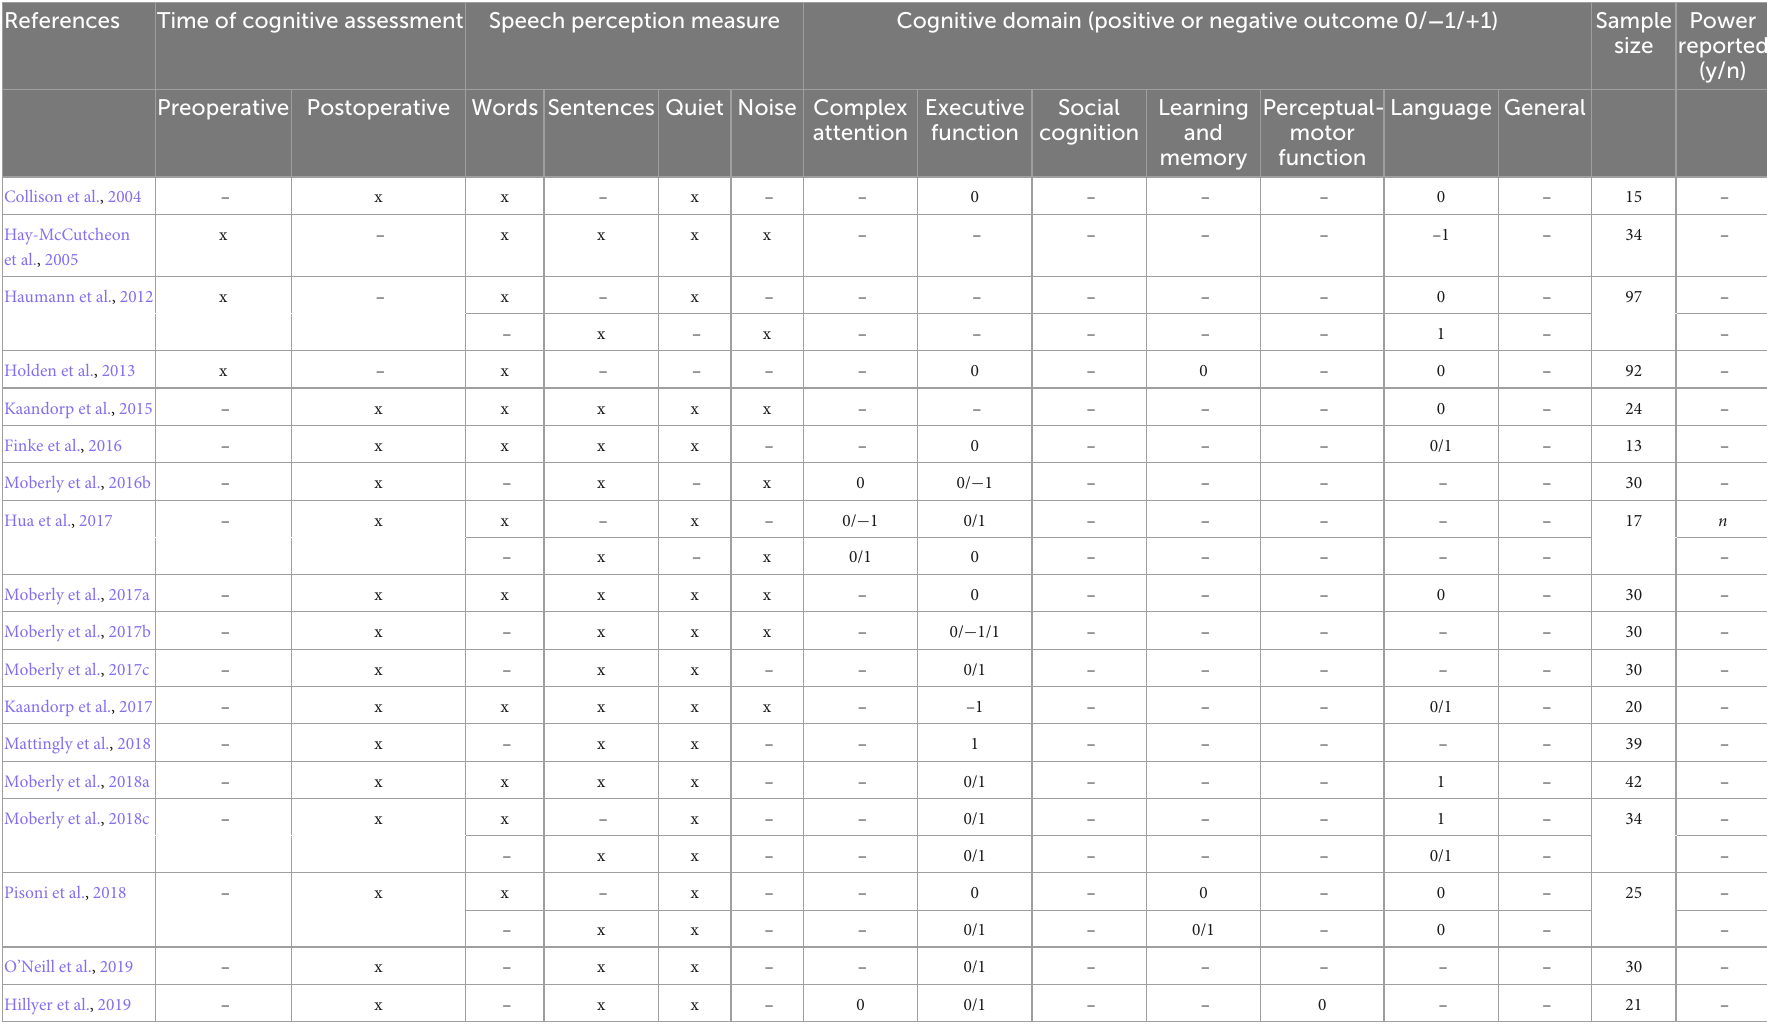
TABLE 4 Overview of included papers involving cognitive and language